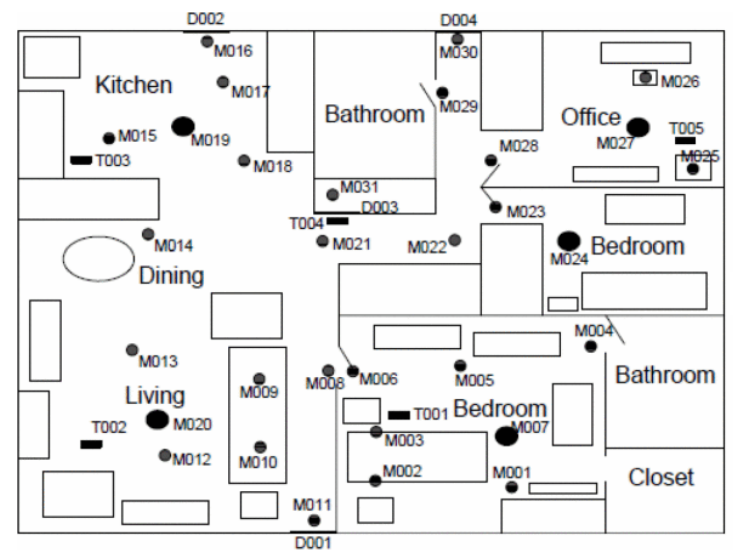
Figure 4. House plant of the apartment for the Aruba dataset [37]. Table 2. Number of sensors per type in every room of the